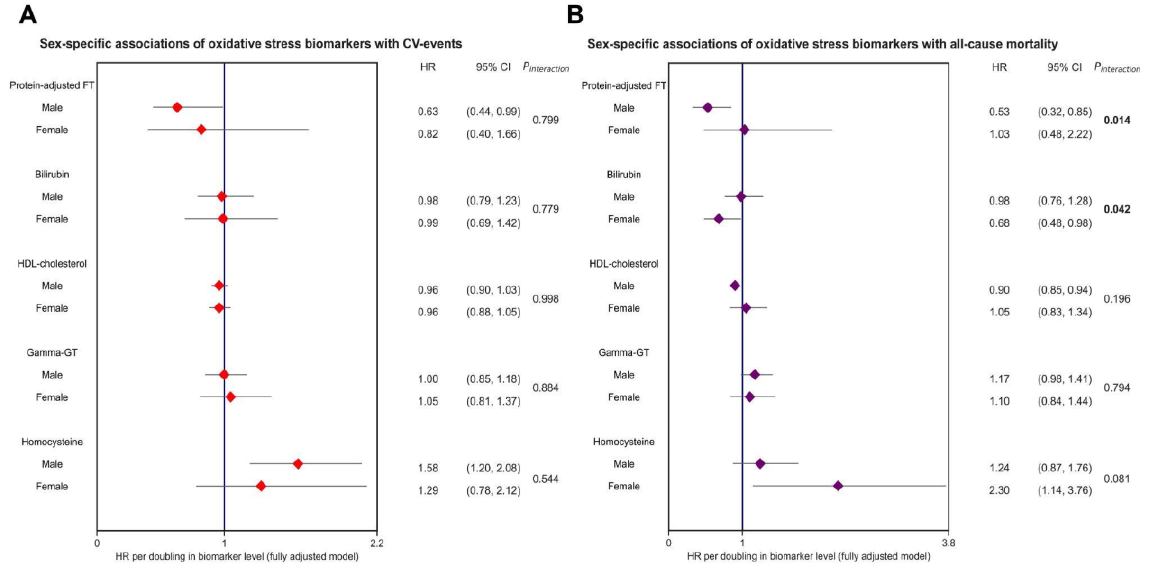
Figure 3. Forest plot showing sex-specific associations of oxidative stress biomarkers and the risk of CV events and all-cause mortality in the general population. Both panels demonstrate hazard ratios (HRs, red and purple dots), with corresponding 95% confidence intervals (CIs) (lines). The strongest and most statistically significant associations were observed for protein-adjusted FT and homocysteine levels, in relation to both CV events and all-cause mortality. All models were adjusted for confounding variables based on the DAG framework (see Figure 1, corresponding with Model 4 ), including age, sex, current smoking, systolic blood pressure, total cholesterol, and history of diabetes. Bold p -values indicate statistically significant sex interactions. Abbreviations: CI, confidence interval; FT, free thiols; GT, gamma-glutamyl transferase; HDL, high-density lipoprotein; HR, hazard ratio. Table 2. Cox proportional hazards regression analyses for associations between oxidative stress bi- omarkers and the risk of incident CVD and all-cause mortality.